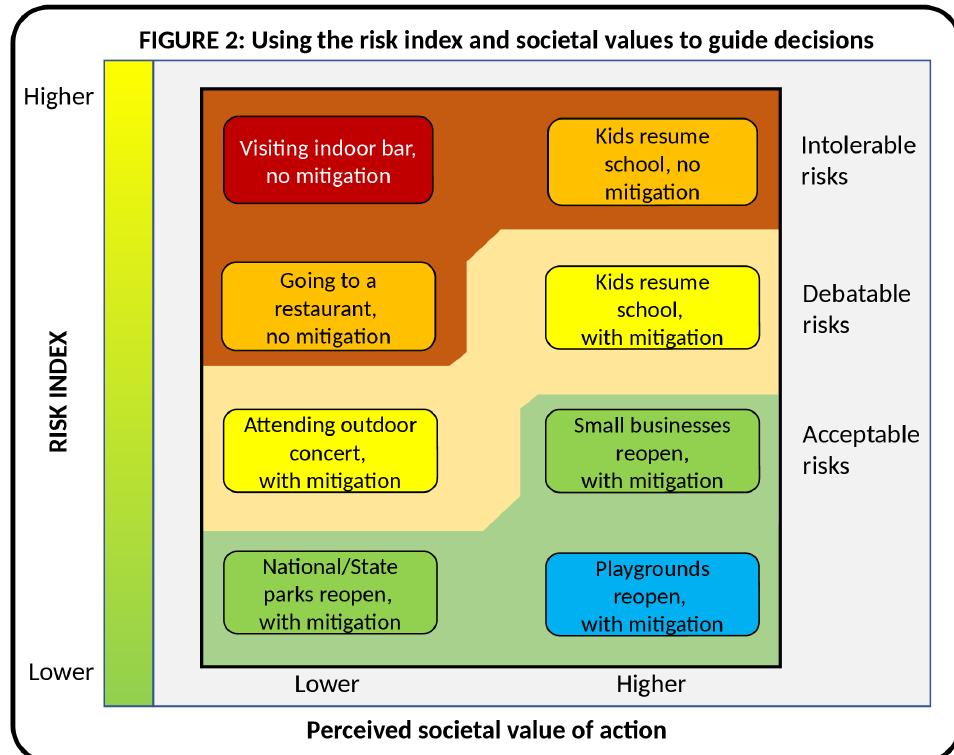
Figure 2. Using the risk index and societal values to guide